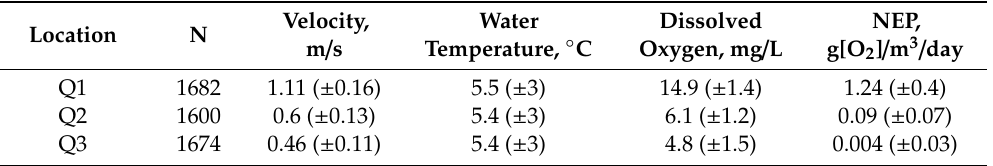
Table 10. Net ecosystem production (NEP) at three locations of the Kanawha River using N number of